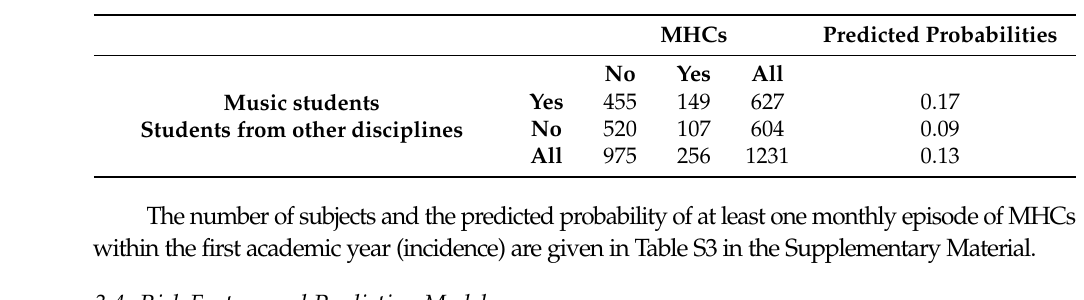
Table 3. Number of monthly episodes of MHCs within subjects’ first academic year and predicted probabilities of MHCs.